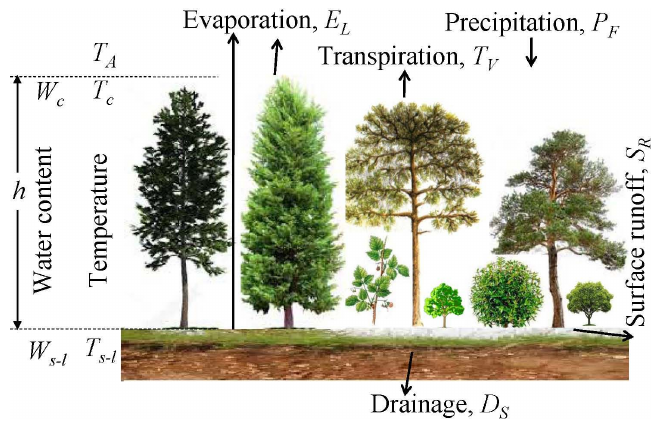
Figure 3. Main scheme of the forest water balance model. Note: W c and W s-l are the water content of the forest canopy and soil-litter, respectively; T A , T c and T s-l are the temperatures of the atmosphere, forest canopy and soil-litter layer, respectively.